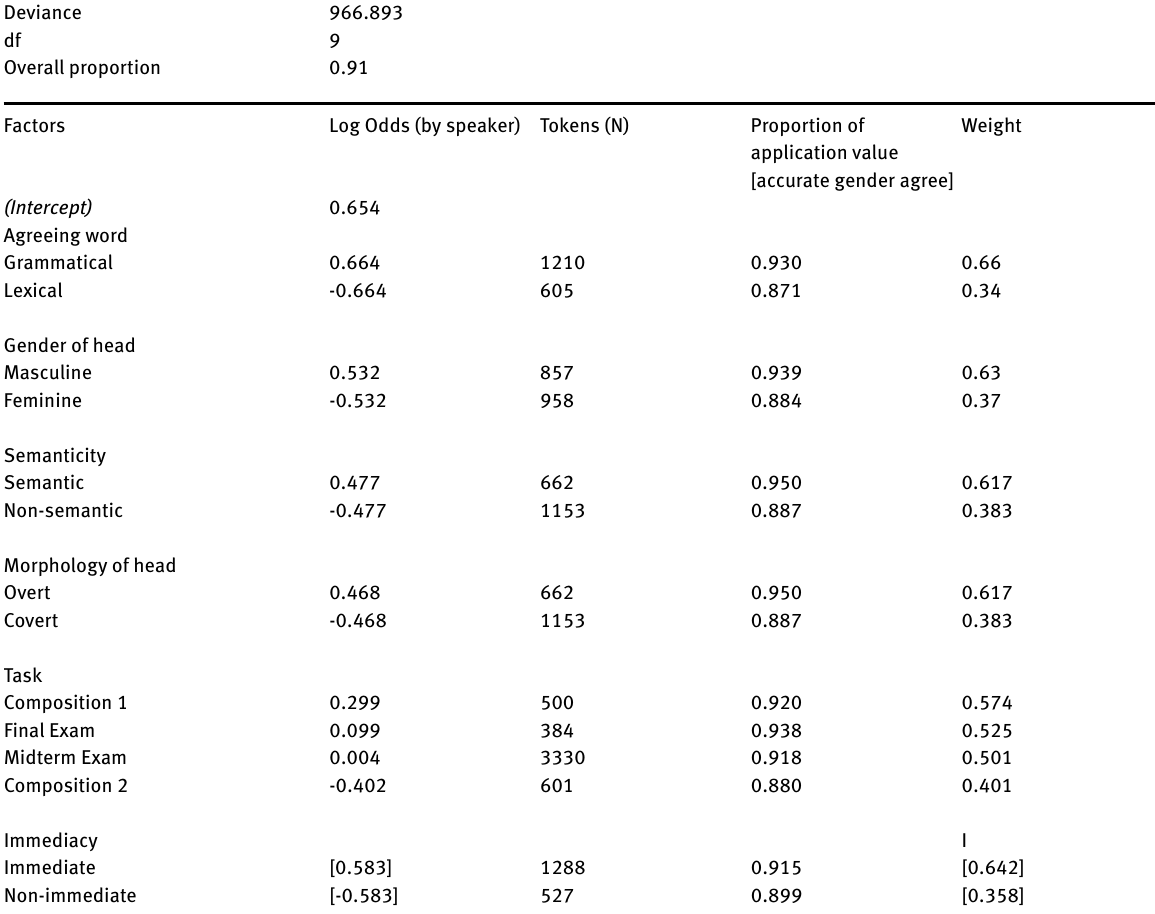
Table 5. Accurate versus inaccurate Spanish gender agreement in Beginning 1 classroom